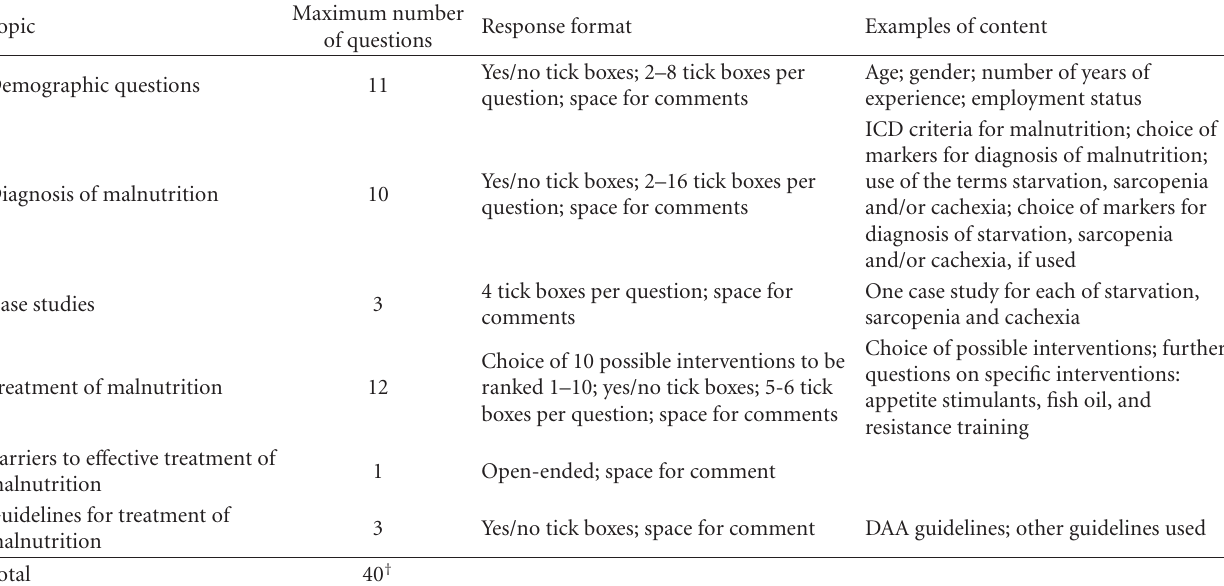
Table 1: Details of online questionnaire used to survey DAA members on perspectives on